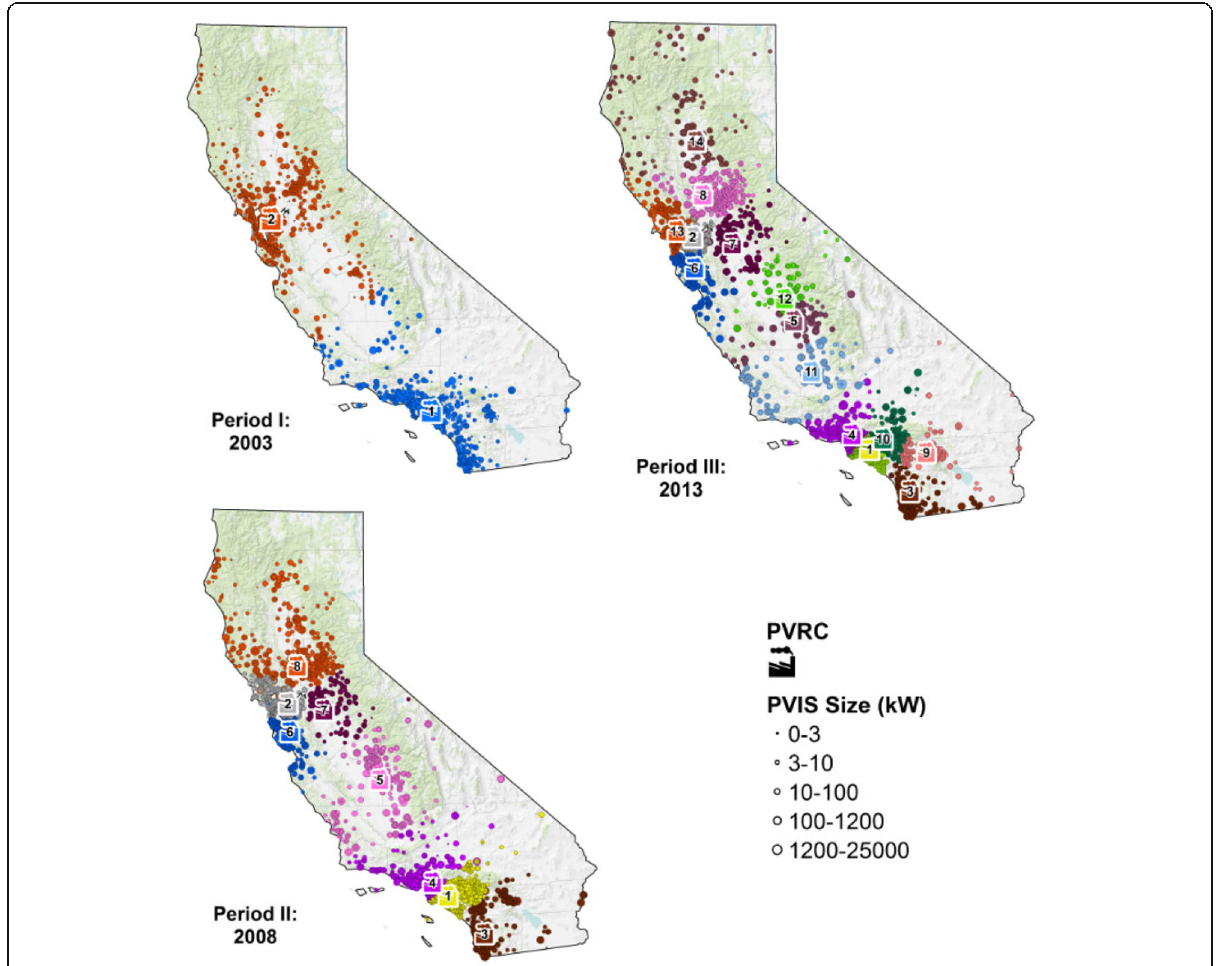
Fig. 3 Distribution decision of year 2003, 2008, and